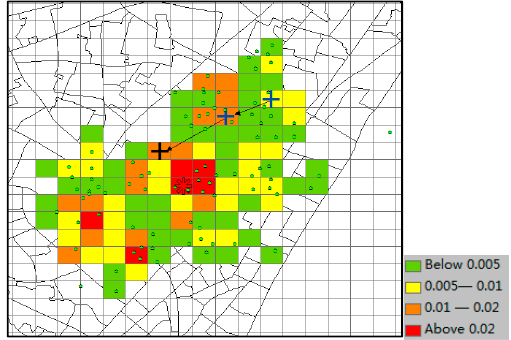
Figure 16. Result of CMoB.